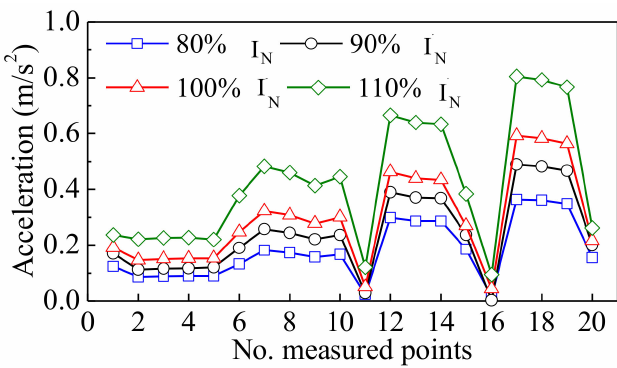
Figure 20. Vibration acceleration at fundamental frequency.